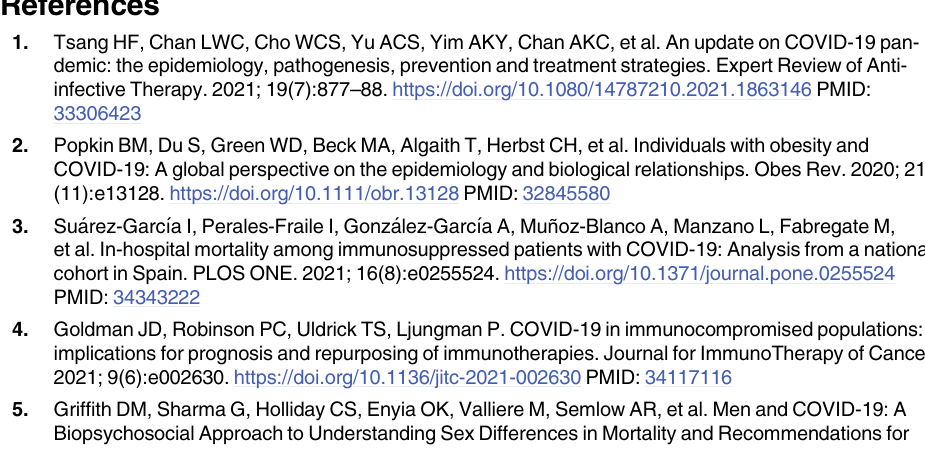
S1 Table. Categorical and quantitative variable